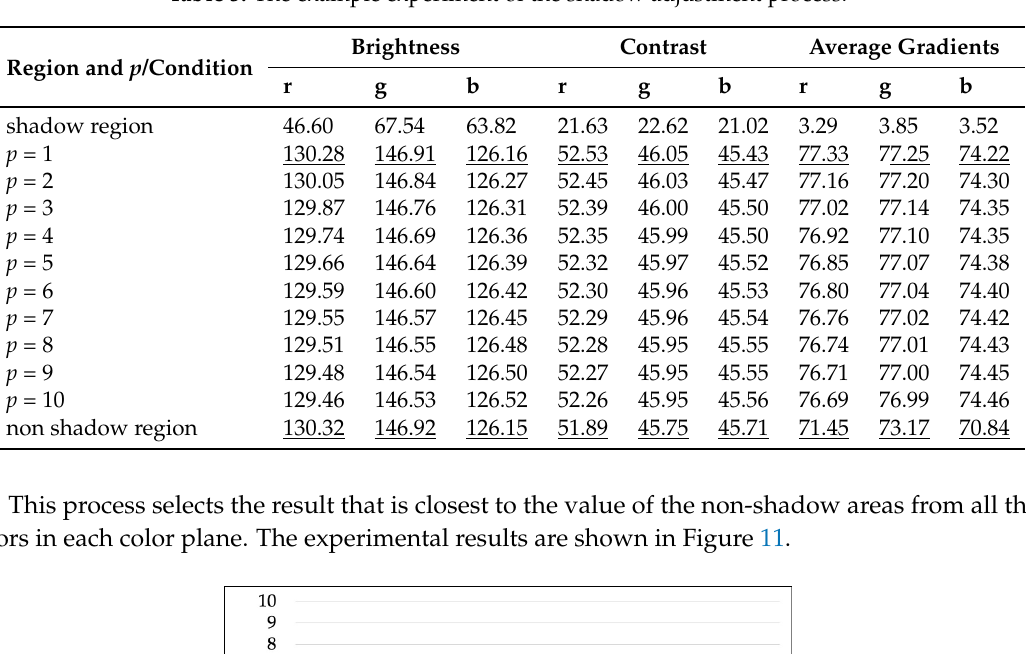
Table 3. The example experiment of the shadow adjustment process.